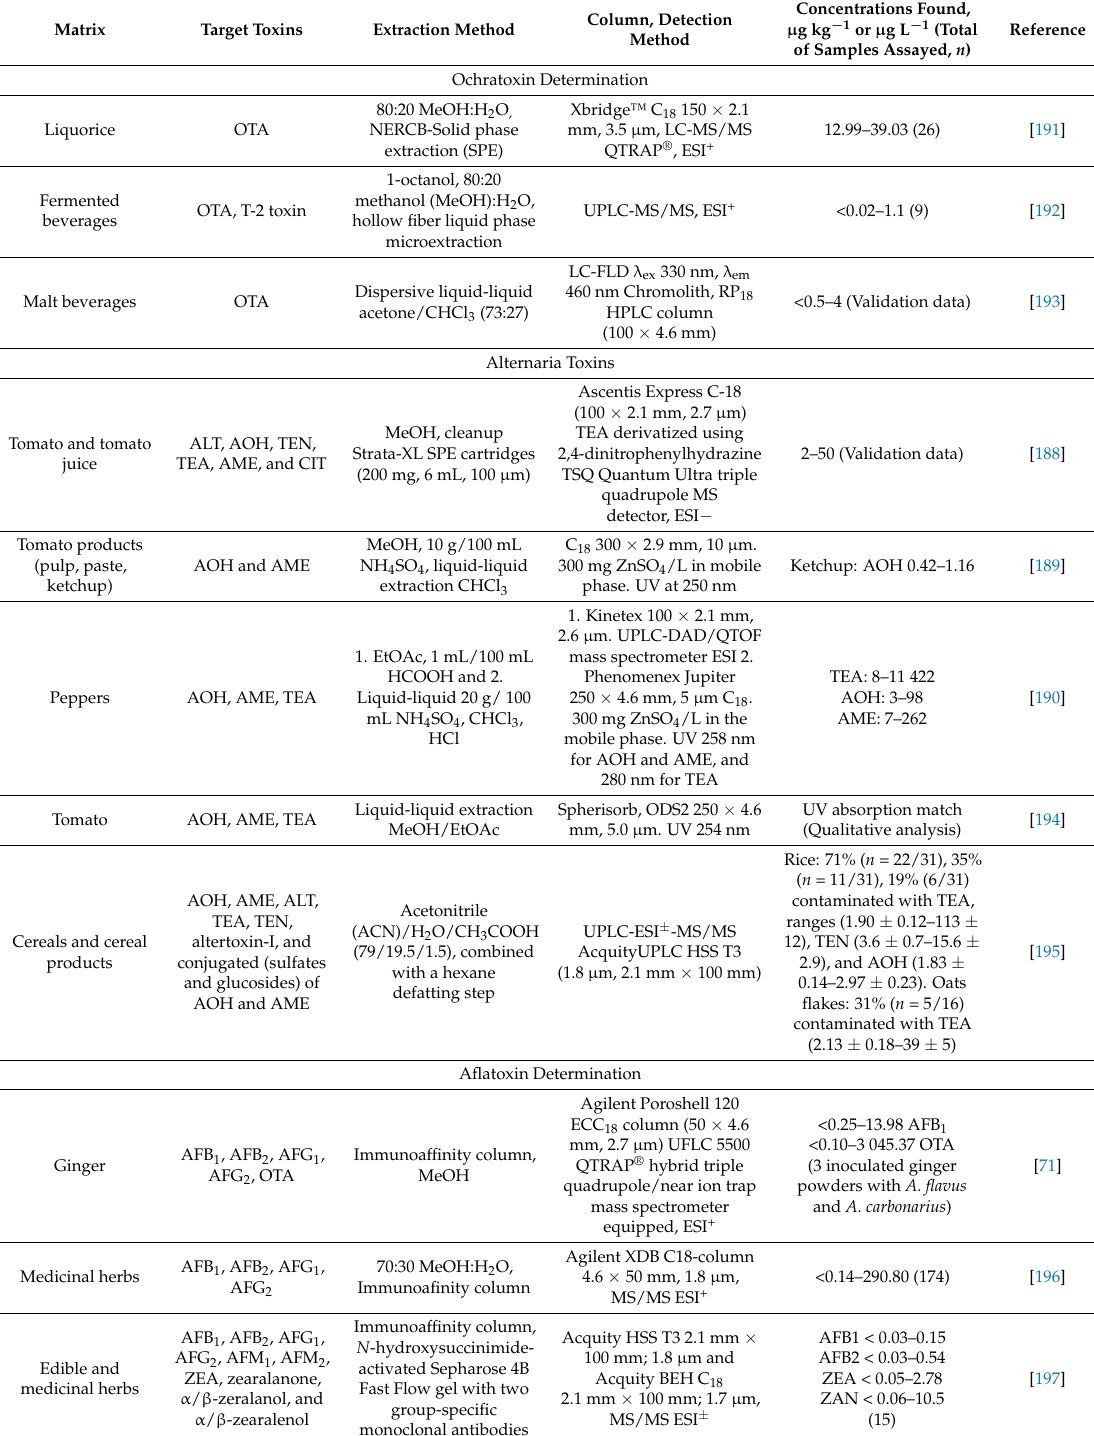
Table 5. Liquid chromatography-based methodological approaches for the determination of multiple toxins in beverages and raw